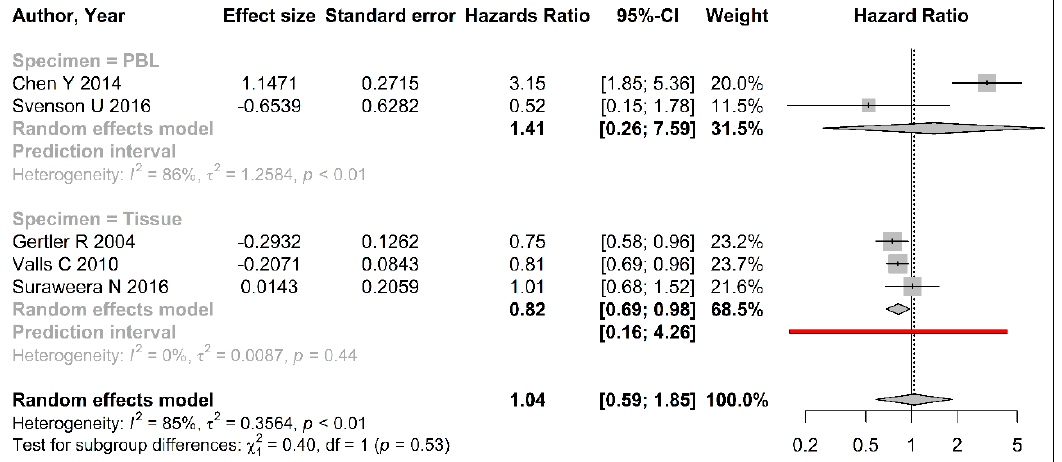
Figure 4. Forest plot summarizing the association between telomere length (comparing shortest quartile vs. longer quartiles) and survival of colorectal cancer within subgroups of peripheral blood leukocytes and tumor tissue using random effects model. (References: Chen Y 2014 [40], Svenson U 2016 [35], Gertler R 2004 [36], Valls C 2010 [37], Suraweera N 2016 [38]) We observed contrasting associations with colorectal cancer survival for leukocyte vs.